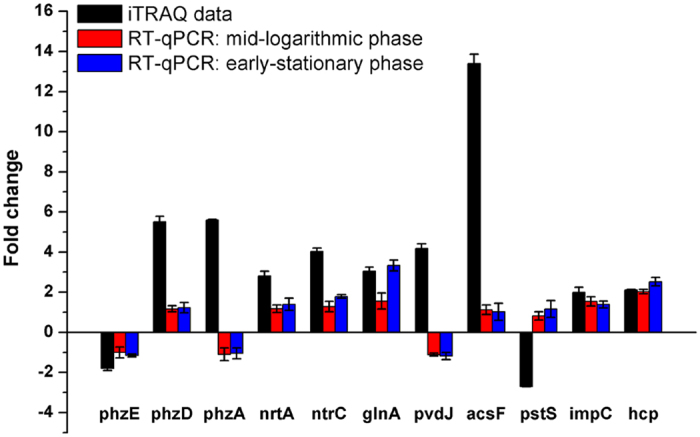
Transcriptional validation of proteomic data using RT-qPCR assays.The value of fold change on the y-axis indicates the ratio of either protein (black bar) or mRNA level at the mid-logarithmic phase (red bar) and early-stationary phase (blue bar).